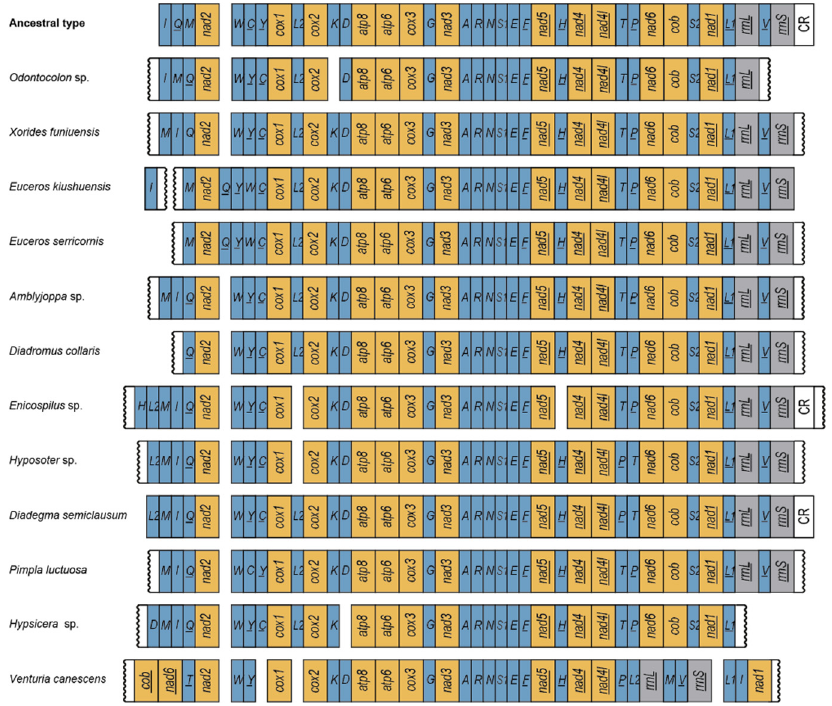
Figure 3. Mitochondrial genome rearrangement patterns of Ichneumonidae referenced with the ancestral insect mitochondrial genomes. PCGs, tRNA genes, rRNA genes and A+ T-rich region (CR region) are marked in orange, blue, grey and white, respectively. tRNA genes are denoted by a one-letter symbol according to the IPUC-IUB single-letter amino acid codes. Genes with underlines indicate that the gene is encoded on the minority strand. Genes with squiggle lines means the breakpoint caused by failure of sequencing. cox1-cox3 : cytochrome oxidase subunits; cob : cytochrome b; nad1-nad6 : NADH dehydrogenase com- ponents; rrnL and rrnS : ribosomal RNAs. Single letters identify the transfer RNA genes—refer to the IPUC-IUB (International Union of Pure and Applied Chemistry-International Union of Biochemistry) single-letter amino acid codes.